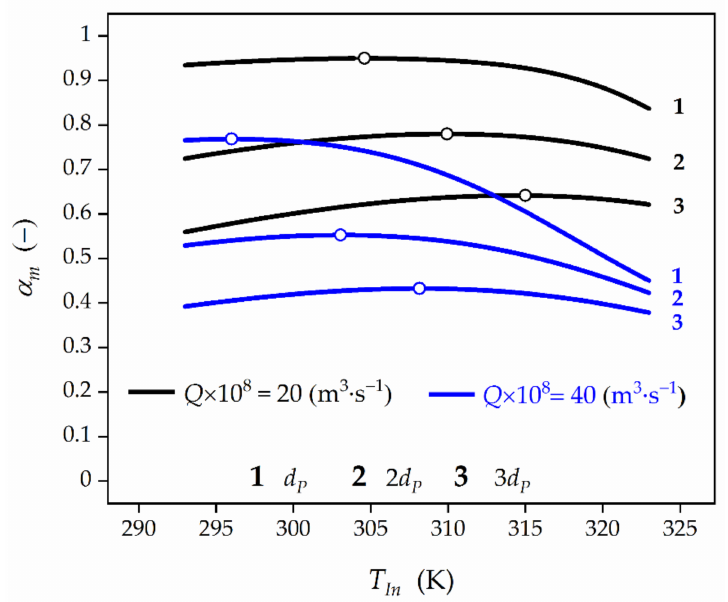
Figure 7. Effect of the feed temperature, T In , and biocatalyst pellet size, d P , on time-averaged HP conversion at the bioreactor outlet for feed HP concentration of C A,In = 3 × 10 − 3 kmol · m − 3 . Black lines represent HP conversion for Q = 20 × 10 − 8 m 3 · s − 1 , while blue lines for Q = 40 × 10 − 8 m 3 · s − 1 , respectively. Open symbols represent the maximum values of HP